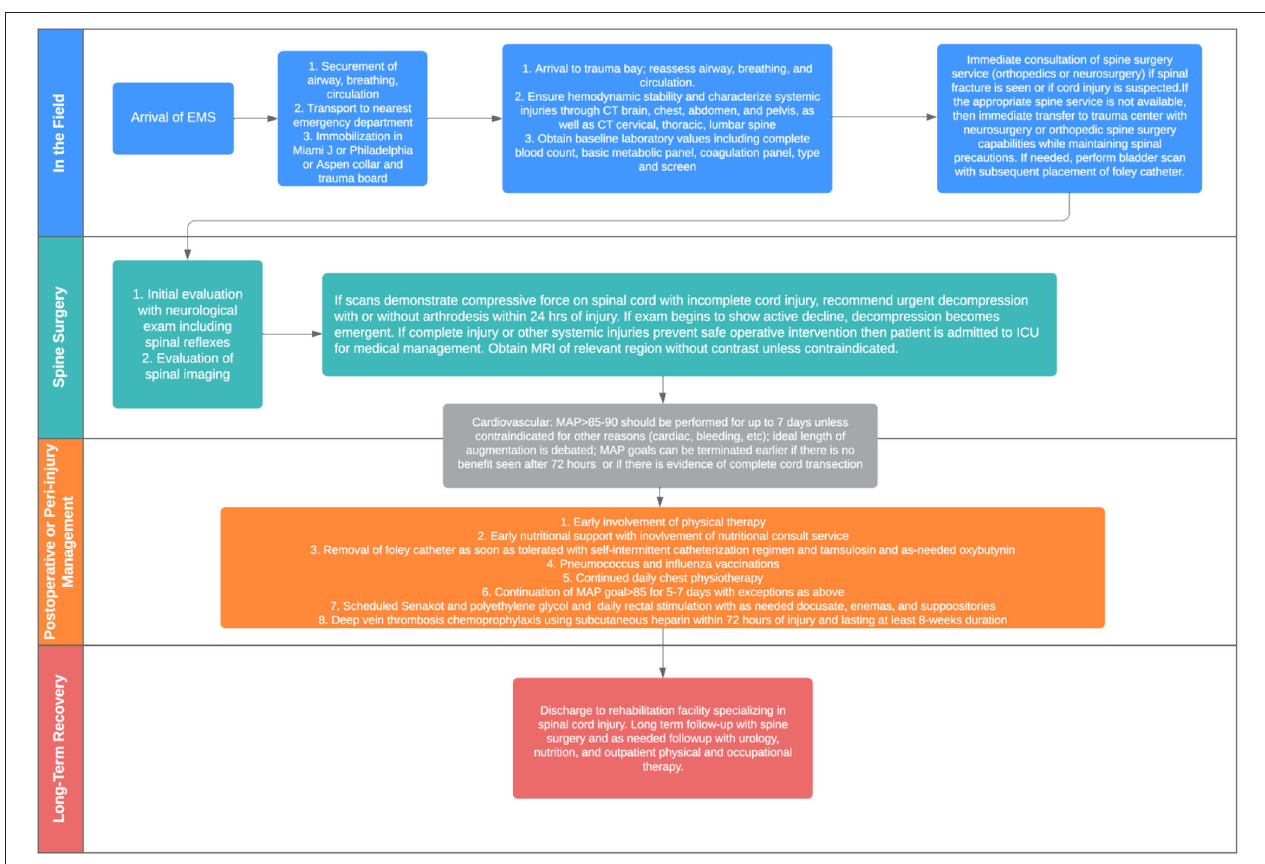
FIGURE 2 | Algorithm for managing acute spinal cord